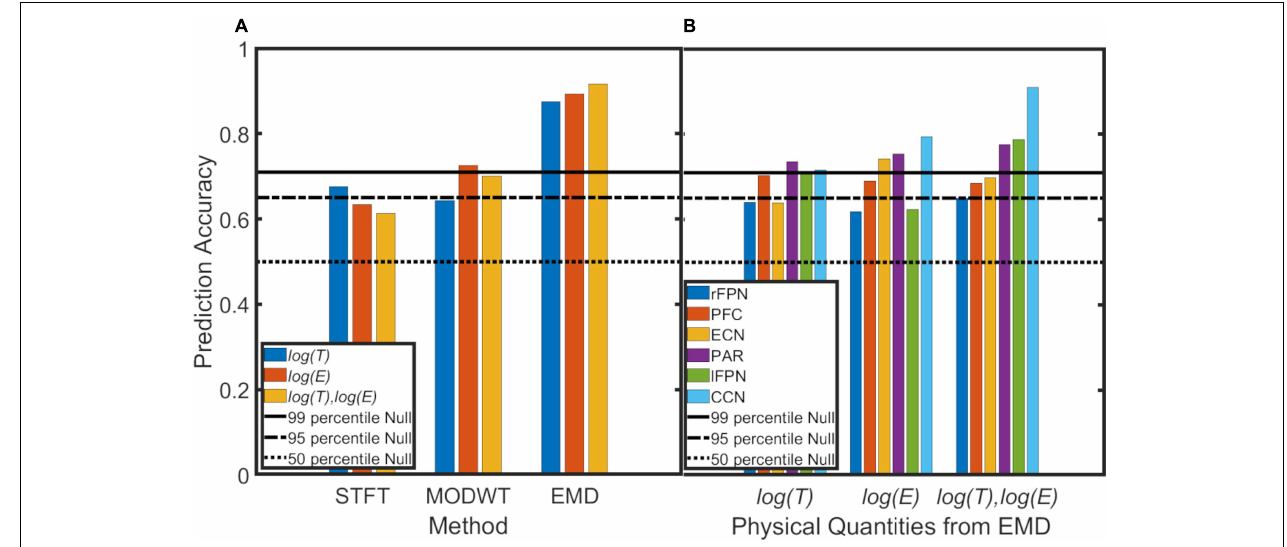
FIGURE 11 | Prediction accuracy of PD vs. NC using a support vector machine and the leave-1-out method applied to 6 brain networks (ECN, PAR, CCN, PFC, lFPN, rFPN) (see Supplementary Material 6) . Black line, dash-dotted line and dotted line represent the prediction accuracy of the null (permutation) distribution at the 99 percentile, 95 percentile and 50 percentiles. (A) Data for all 6 networks were combined. EMD (with all 5 IMFs combined) shows the highest prediction accuracy for period (log(T)) information (blue), for energy (log(E)) information, or both period and energy (log(T),log(E)) information combined. Overall, the Short-Time Fourier Transform (STFT) shows lowest prediction accuracy and the Maximal Overlap Discrete Wavelet Transform (MODWT) performs intermediate. (B) Network-specific prediction accuracies for EMD (with all 5 IMFs combined). Period information of all 6 networks are either very close or above the 95 percentiles of the null distribution. For energy values, only the prefrontal cortex network (PFC), executive control network (ECN), parietal network (PAR) and cognitive control network (CCN) are significant (above the 95 percentiles of the null distribution) whereas the right and left frontoparietal networks (lFPN, rFPN) do not reach significance. Combining period and energy information yields significance for all of the 6